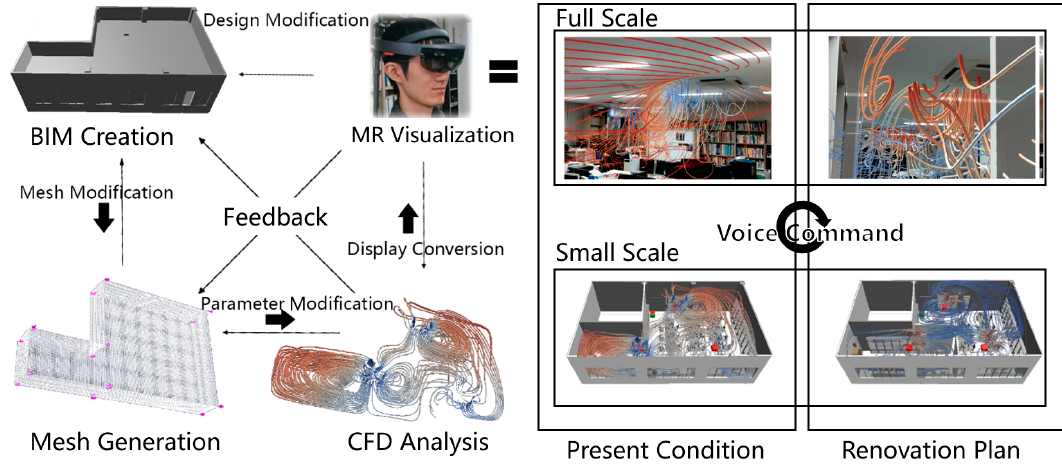
Figure 1. System Figure 1. System overview.